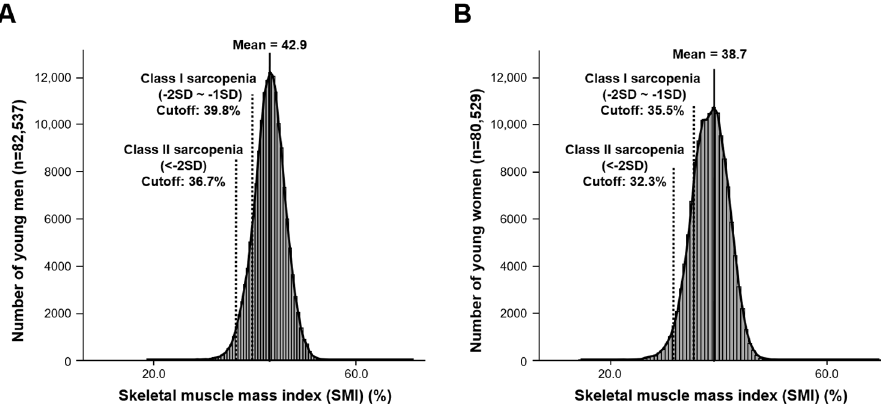
Figure 2. Number of ( A ) young men and ( B ) young women according to SMI and threshold levels for class I and class II sarcopenia. SMI, skeletal muscle mass index. SMI = skeletal muscle mass index.